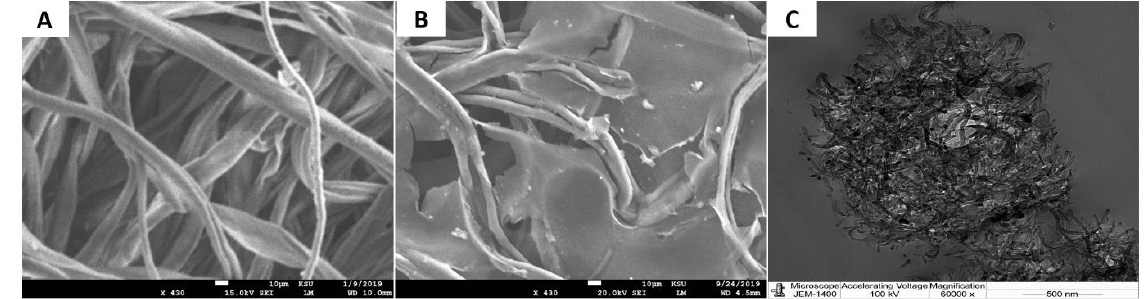
Figure 1. ( A , B ) SEM images of the untreated cotton and the conductive nanocomposite cotton at a concentration of 36.75 wt%; ( C ) TEM of the conductive nanocomposite cotton.